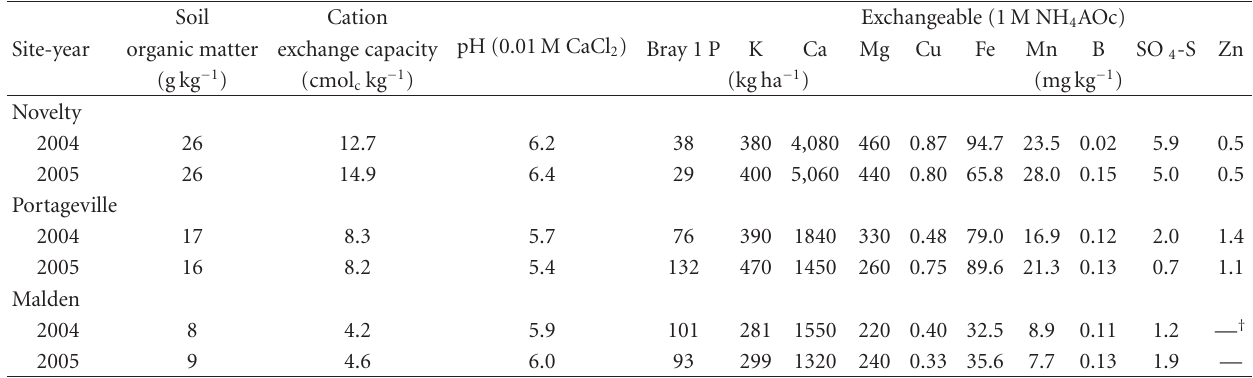
Table 1: Soil test values for Novelty, Portageville, and Malden in 2004 and 2005.